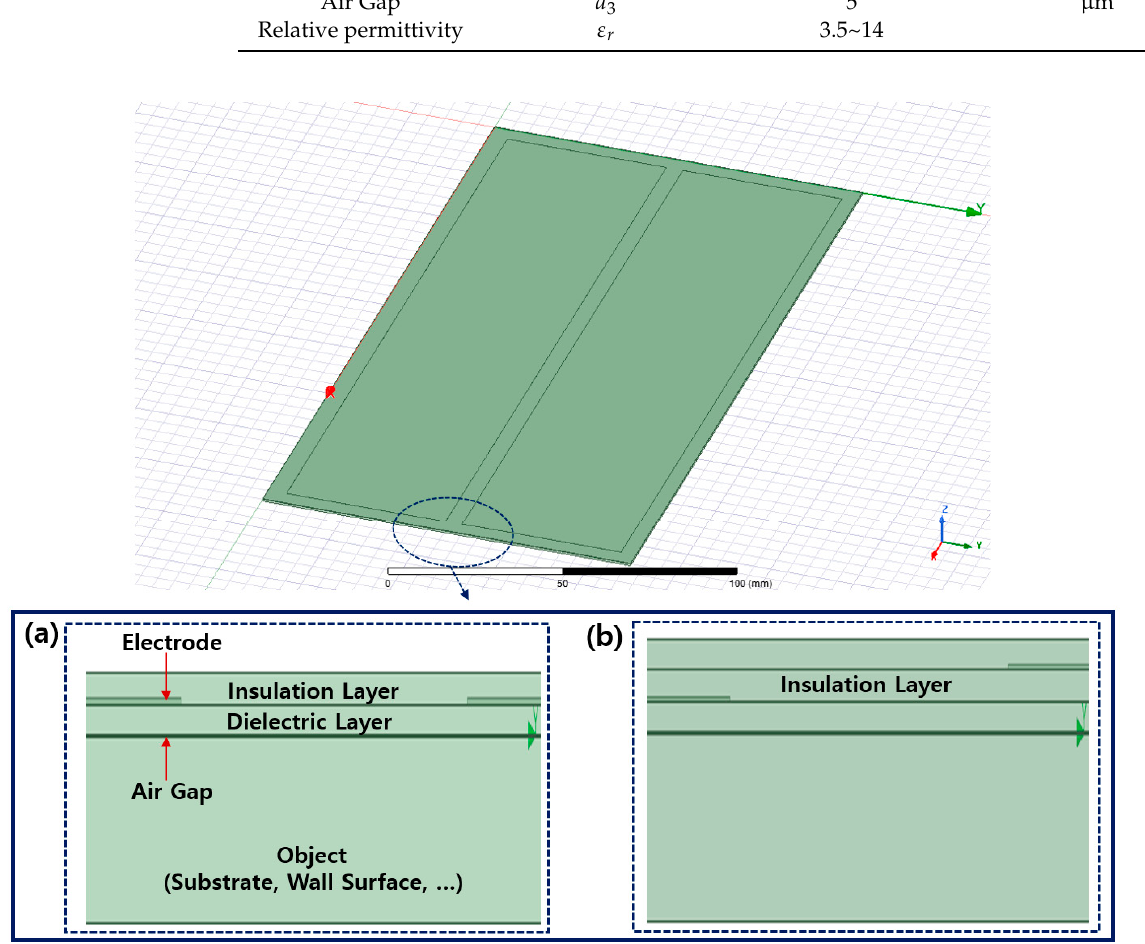
Figure 6. Electroadhesion pad modeling: ( a ) one-insulation layer type; ( b ) dual-insulation layer type.